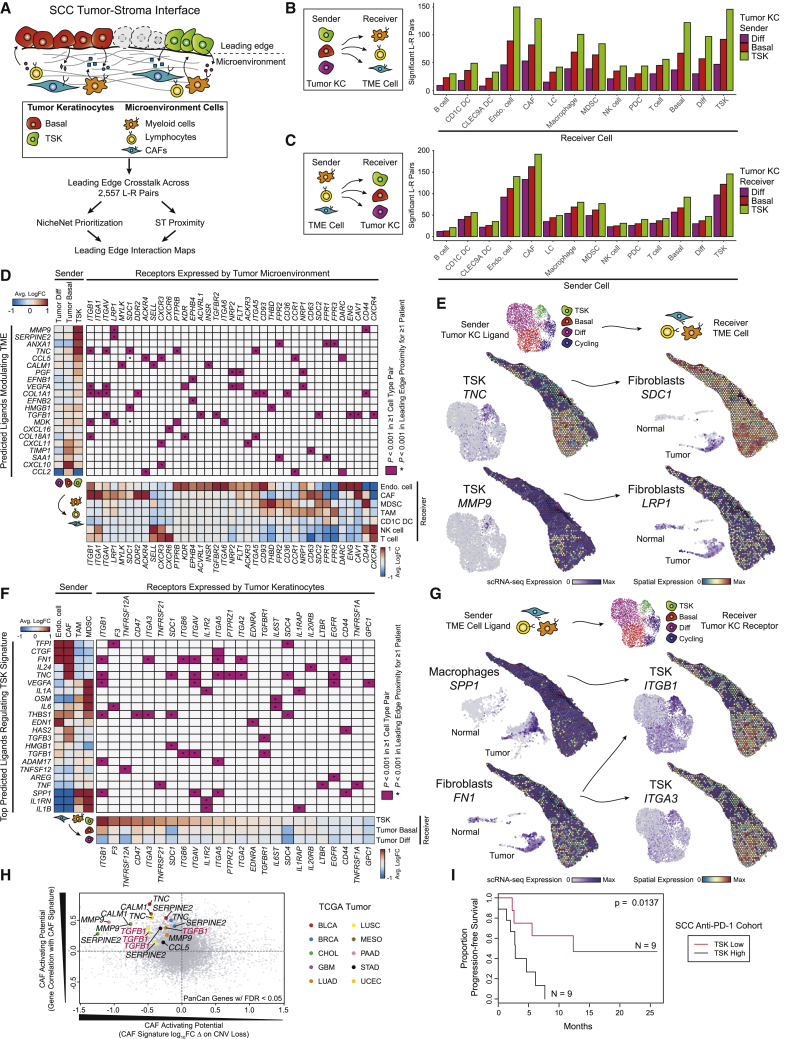
Cellular Crosstalk Landscape Associated with Leading Edge Niches(A) Schematic of combined scRNA-seq and ST ligand-receptor analysis of tumor keratinocyte (KC) subpopulations at the leading edge and TME cells.(B and C) Bar plots of significant ligand-receptor (L-R) pairs (p < 0.001, permutation test; STAR Methods) when tumors express ligands (B) or receptors (C) matched to cell types in scRNA-seq data.(D) Left, heatmap of scRNA-seq average log fold change (logFC) across normal and tumor KC subpopulations of NicheNet top predicted ligands expressed by tumor KCs that modulate TME cell types. Bottom, heatmap of scRNA-seq average logFC of ligand-matched receptors expressed by TME cell types. Middle, heatmap of significant ligand-receptor pairs between ≥1 tumor KC subpopulation and TME cell type pair in scRNA-seq.(E) UMAP scRNA-seq (N = 7 patients) and spatial feature plots (patient 4) of select ligands expressed by tumor KC subpopulations and cognate receptor expression by TME cell types.(F) Left, heatmap of scRNA-seq average logFC of NicheNet top predicted ligands expressed by TME cells that modulate the TSK signature. Bottom, heatmap of scRNA-seq average logFC of ligand-matched receptors across normal and tumor KC subpopulations (only tumor shown). Middle, heatmap of significant ligand-receptor pairs between ≥1 TME cell type and tumor KC subpopulation pair. ∗indicates spatial transcriptomic proximity p < 0.001 (permutation test; STAR Methods) in ≥1 patient in (D) and (F). Average logFCs in heatmaps from (D) and (F) were calculated using Wilcoxon rank-sum test.(G) UMAP scRNA-seq (N = 7 patients) and spatial feature plots (patient 4) of select ligands expressed by TME cell types and cognate receptor expression by tumor KC subpopulations.(H) Scatterplot of TCGA (31 cancer types) correlation values between single genes and CAF-signature expression (y axis) (FDR <0.05; STAR Methods) and effect of CNV loss on CAF-signature expression (x axis). TSK ligands are labeled and colored by cancer type. Known CAF activator TGFB1 is highlighted in red.(I) Kaplan-Meier plot of progression-free survival after PD-1 inhibitor treatment of patient SCC (HNSC and LUSC) tumors exhibiting high and low TSK-associated gene expression (p value, chi-square test).See also Figure S6.